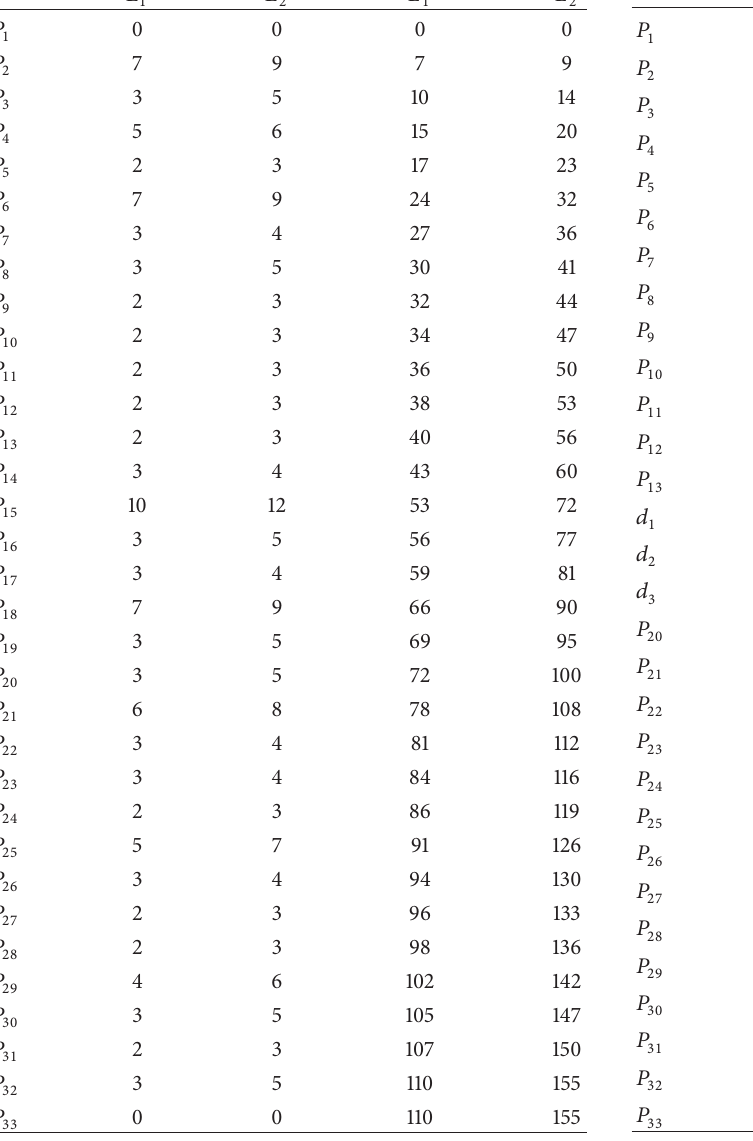
Table 3: Upper and lower time limit corresponding to each Place before being optimized.